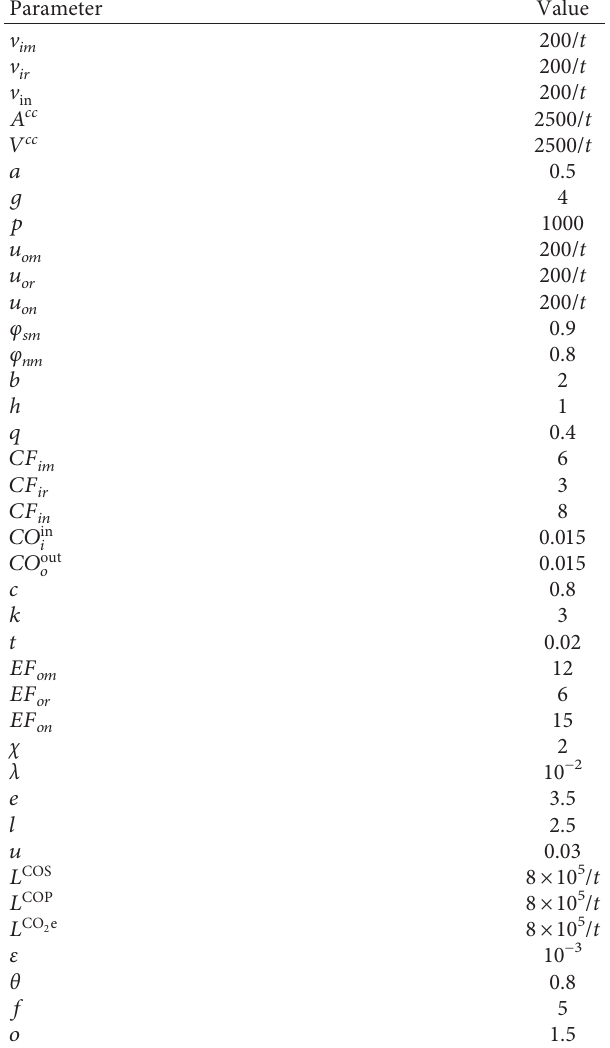
Table 3: Parameter setting.